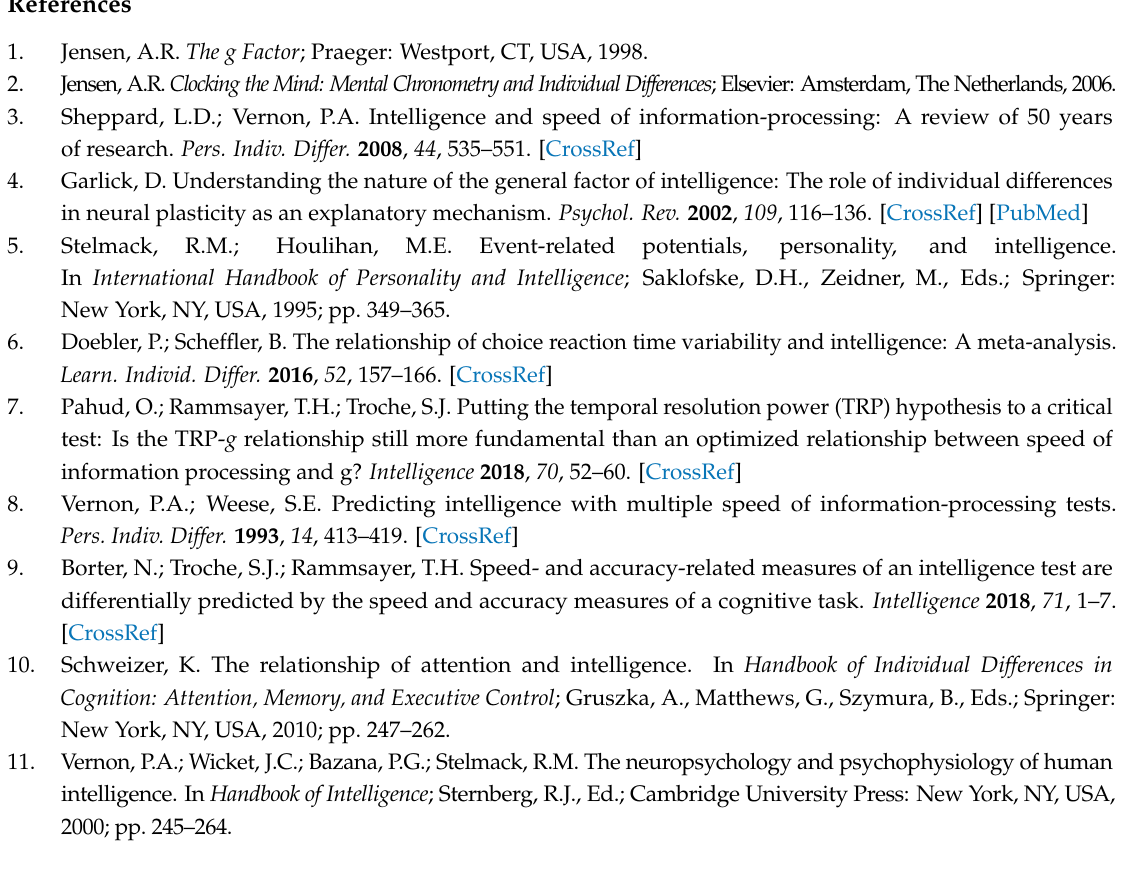
Figure S1: Grand averages (solid lines) and standard deviations (dotted lines) of the event-related potentials in the three CPT conditions; Figure S2: Grand average (solid line) and standard deviation (dotted line) of the event-related potentials in the CPT0 condition; Figure S3: Grand average (solid line) and standard deviation (dotted line) of the event-related potentials in the CPT1 condition; Figure S4: Grand average (solid line) and standard deviation (dotted line) of the event-related potentials in the CPT2